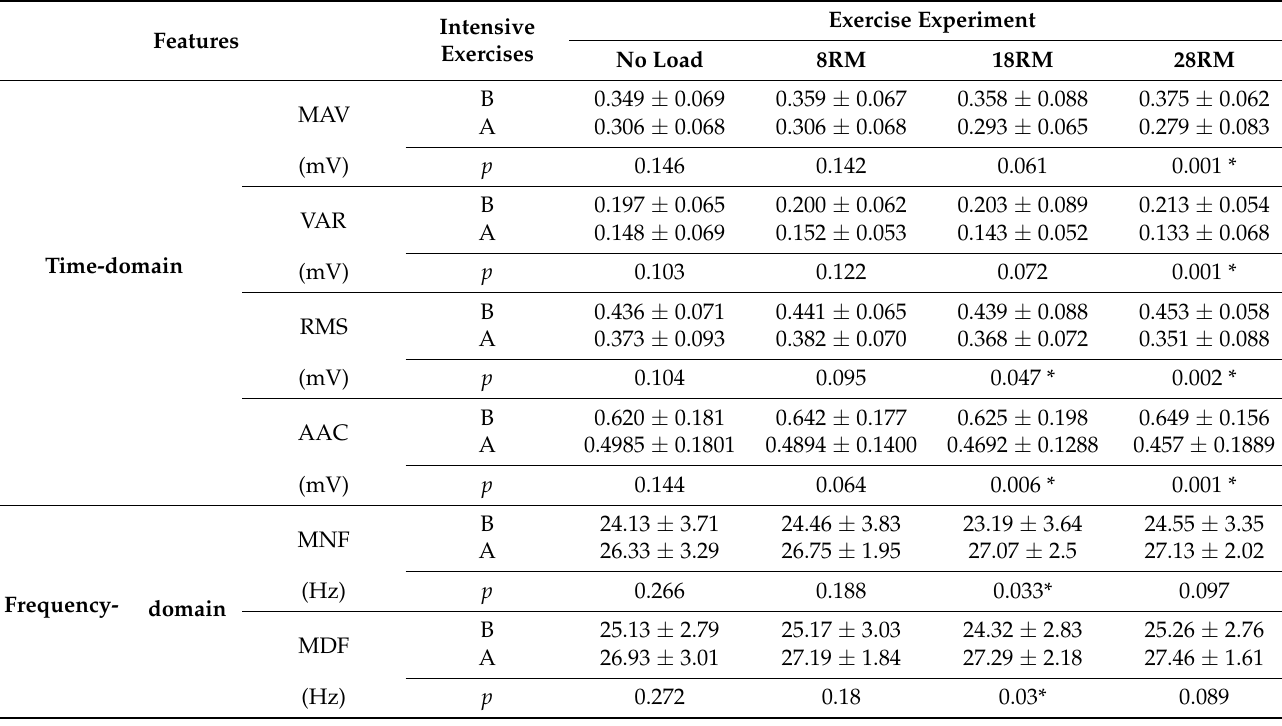
Table 3. Statistical analysis of EMG features in force plate experiment (Mean ± SD).